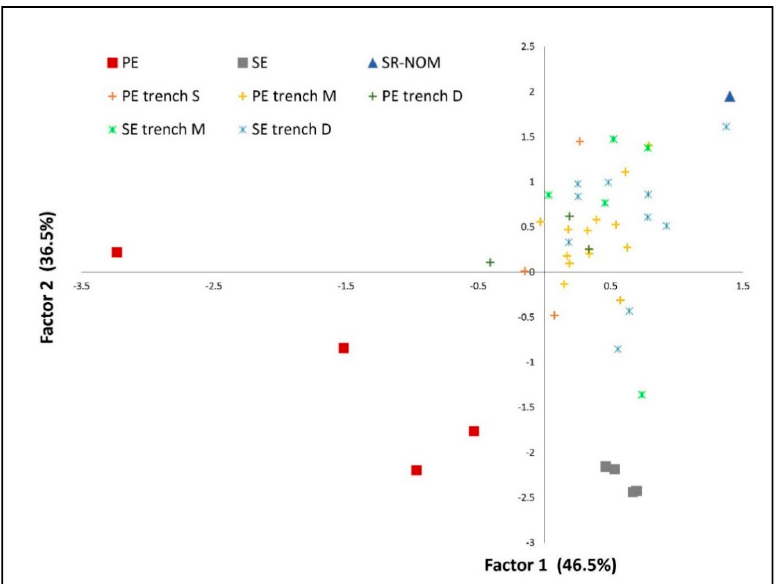
Figure 5. Biplot for primary effluent (PE) and secondary effluent (SE) trench samples from February and March 2017 using the relative proportion of the PARAFAC components as variables for the statistical analysis. S, M, and D indicates the sampling depth within the trench (S: <15 cm, M: 15–34 cm, D: 35–55 cm). For comparison effluent samples and Suwannee River NOM (SR-NOM) are in- cluded.